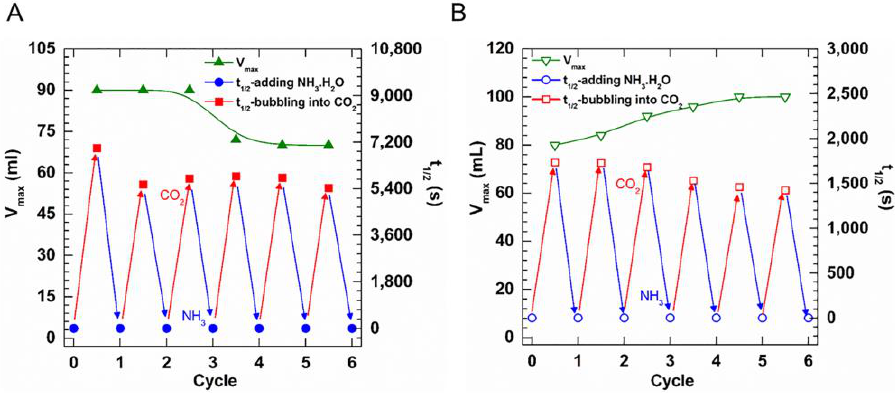
Figure 4. Variation in V max and t 1/2 of ( A ) 0.5% UC 22 AMPM and ( B ) 0.5% UC 18 AMPM foams treated with CO 2 followed by NH 3 · H 2 O, respectively.